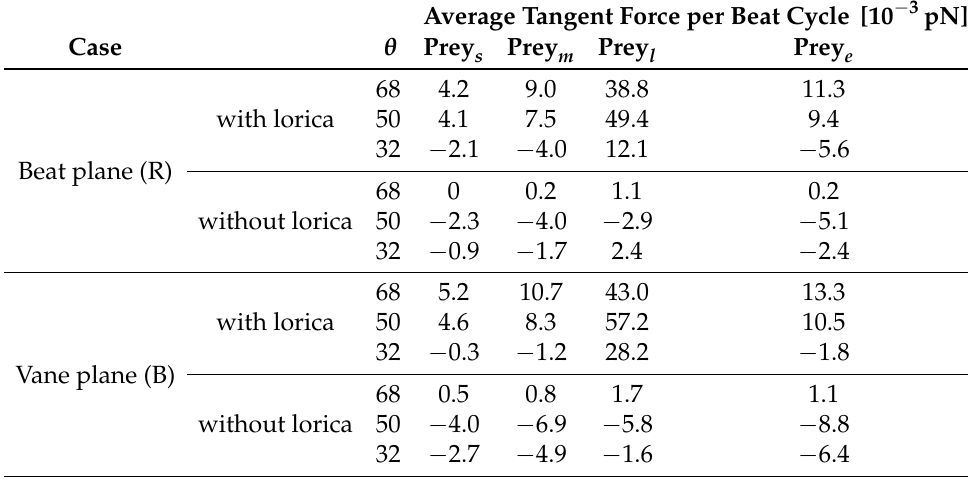
Figure 5. Planar views of an instantaneous flow field velocity simulated without the presence of prey. ( A ) Beat plane view with the lorica. ( B ) Beat plane view without the lorica. ( C ) Vane plane view with and without the lorica, respectively. ( D ) Horizontal view through the collar at position θ = 50 ◦ , pictured with and without the lorica, respectively. Table 3. Time-averaged tangent forces on prey during one flagellum beat cycle for both the loricate and the non-loricate choanoflagellate. One position in the beat plane (R) and one position in the vane plane (B) are shown. Column-wise, the table depicts the effects of prey size and shape variations. Row-wise, the effects of the longitudinal position on the collar ( θ ) can be